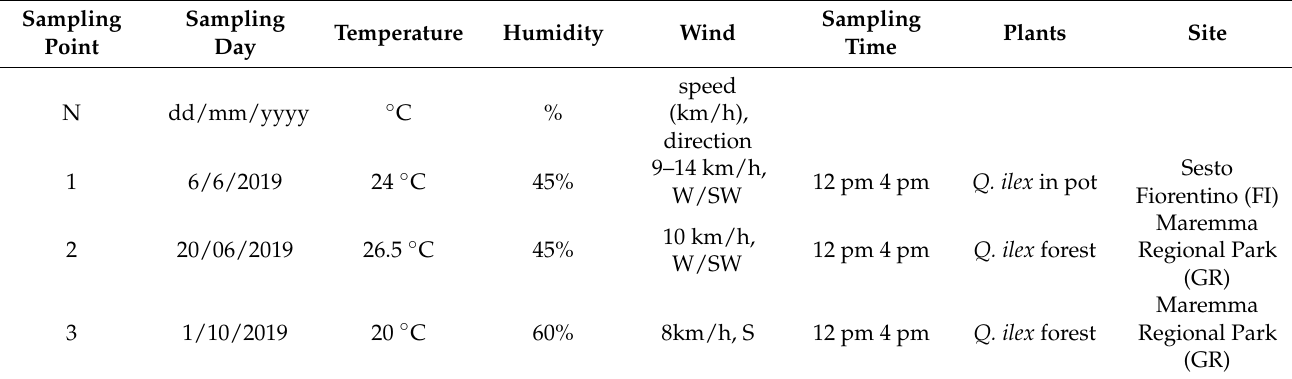
Table 2. The table shows the main atmospheric and sampling parameters: days of sampling, atmospheric temperature and humidity, speed and direction of wind, time window of sampling and site characteristics.